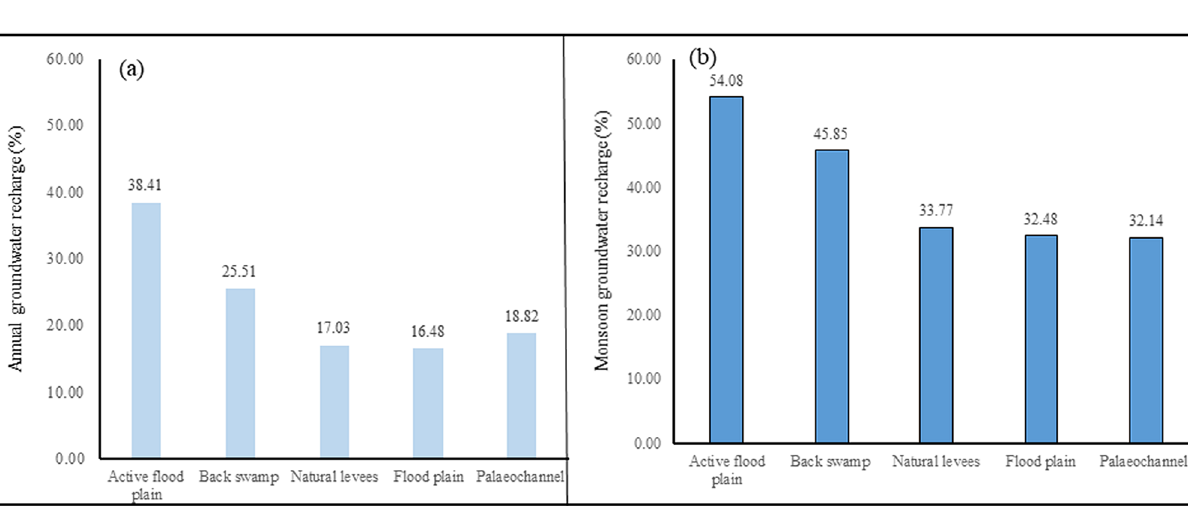
Figure 6. Percentage (%) of natural groundwater recharge due to the ( a ) annual, and ( b ) monsoon rainfall in the geomorphic units in a part of the Ganga